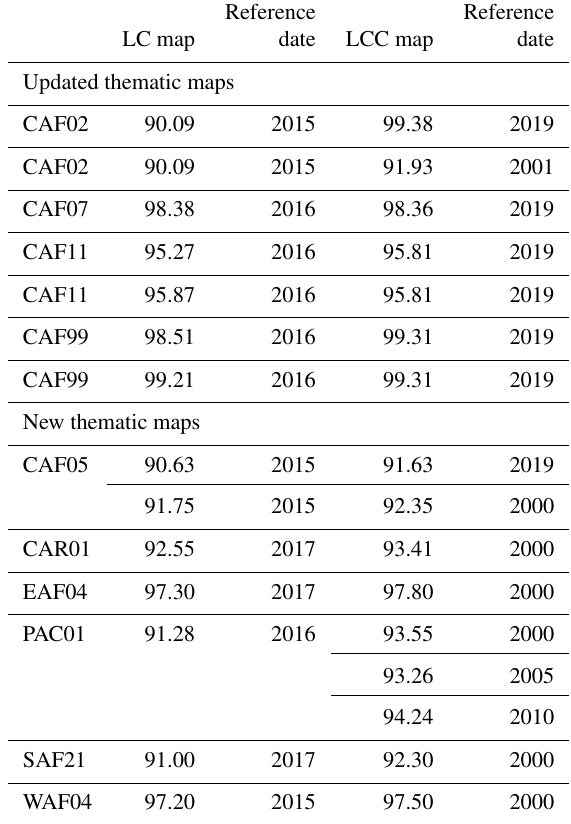
Figure 4. Spatial distribution of the validation datasets within the new key landscapes for conservation.